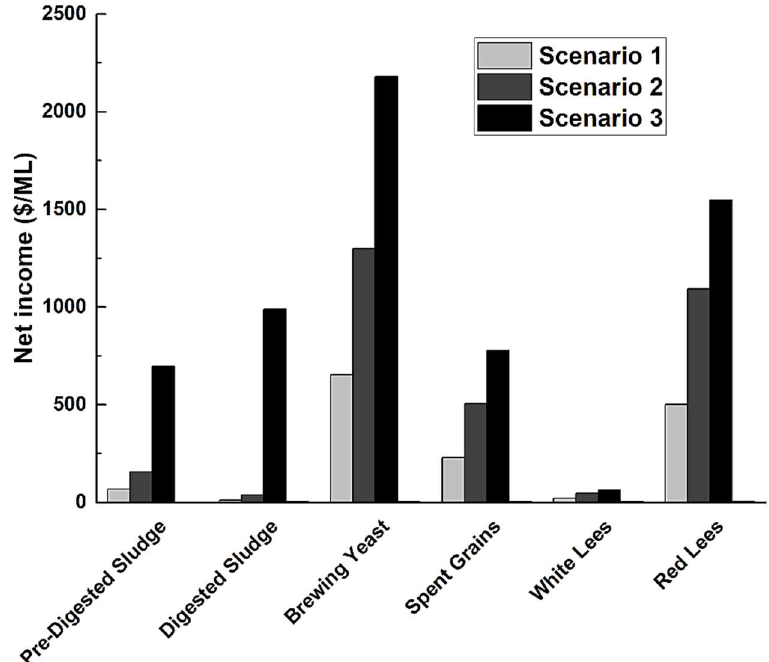
Figure 3. Economic analysis of the benefit of the precipitation of struvite from post-HTL ACP of select waste feedstocks as a means of management of ACP through the removal of NH 4+ and PO 43− .